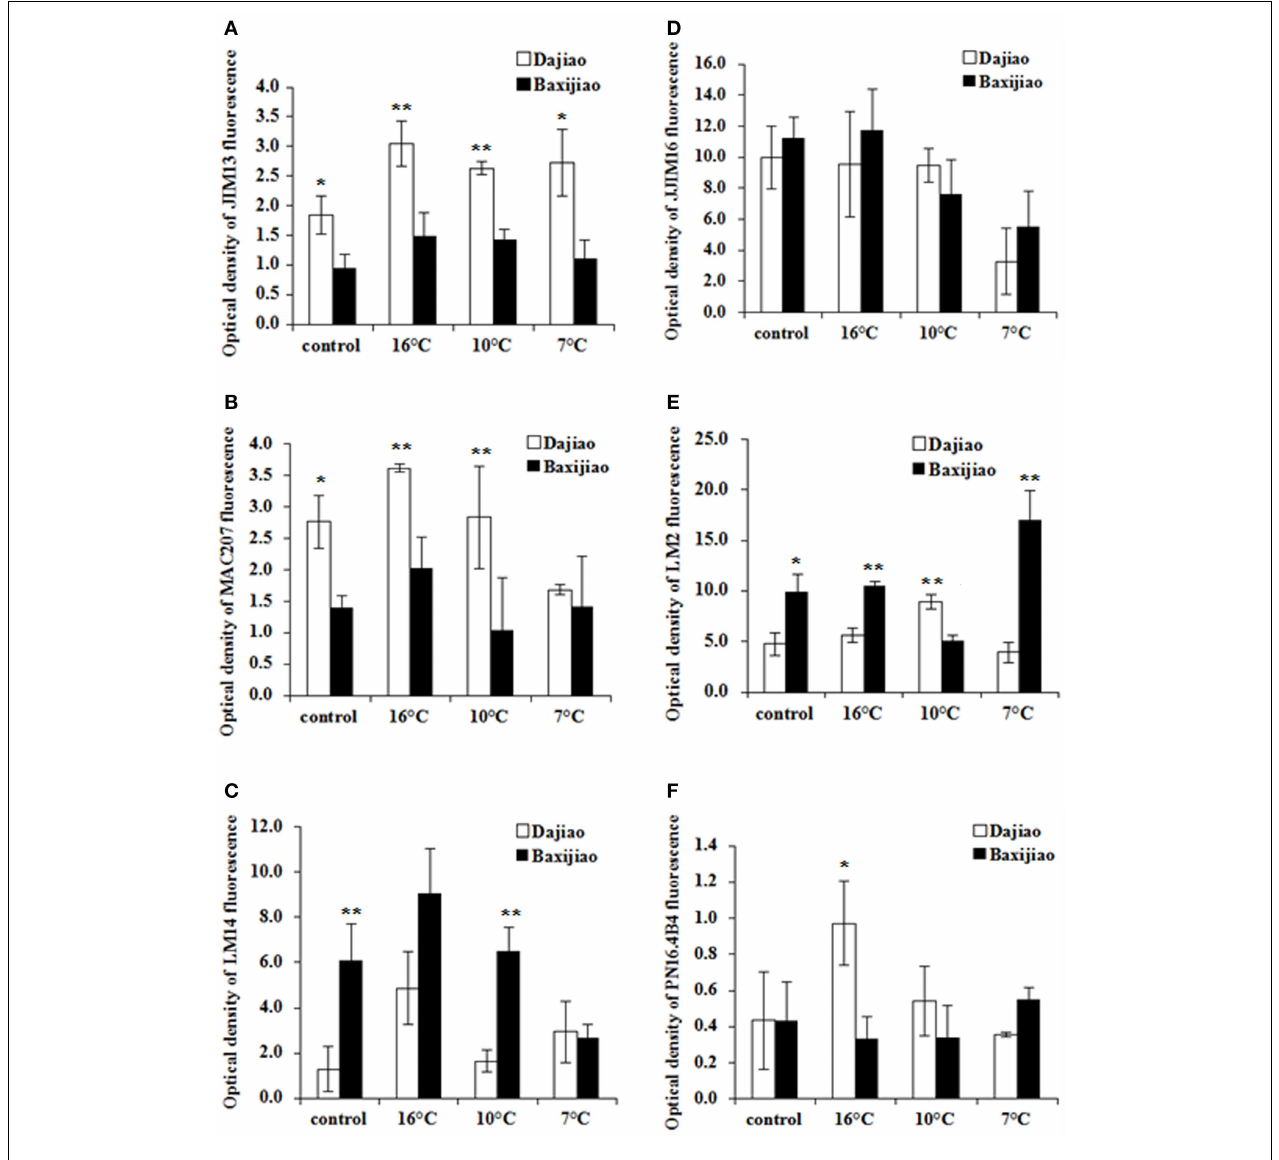
FIGURE 10 | The optical density of the fluorescence signal of arabinogalactan proteins labeled by JIM13, MAC207, LM14, JIM16, LM2, and PN16.4B4 antibodies in banana ( Musa spp.) roots after low temperature stress. (A) JIM13; (B) MAC207; (C) LM14; (D) JIM16; (E)